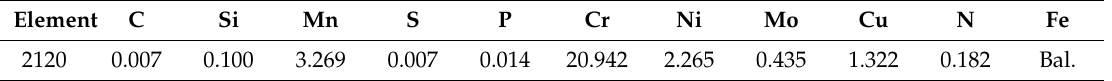
Table 1. Chemical compositions of NSSC 2120 (mass fraction,